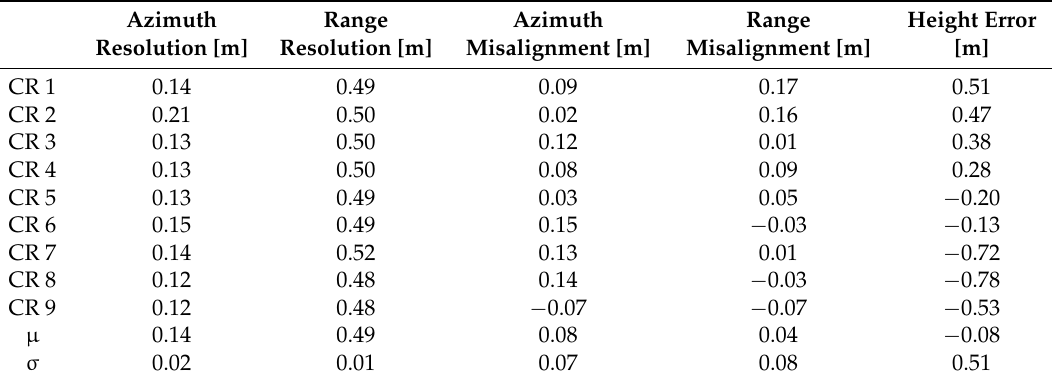
Table 6. Measurements on corner